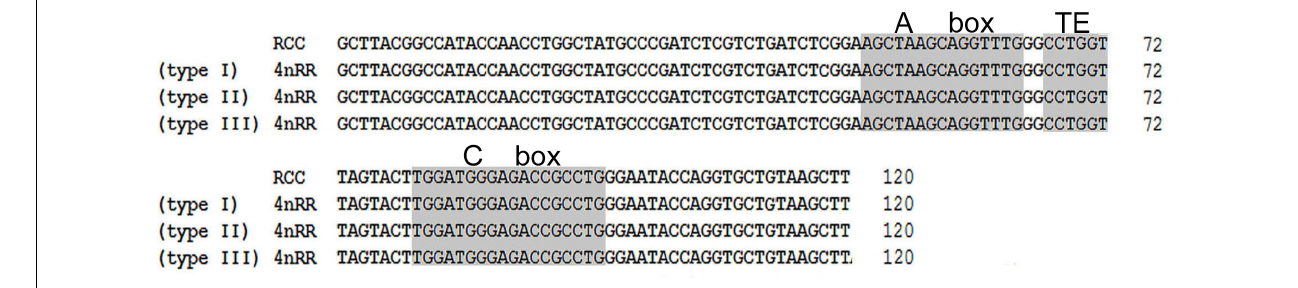
fragment was formed by 72 bp of the type I (a 51 bp of the NTS and 21 bp gene sequence) and 280 bp of type II (the 99 bp of gene sequence and 181 bp of NTS) ( Figure 5